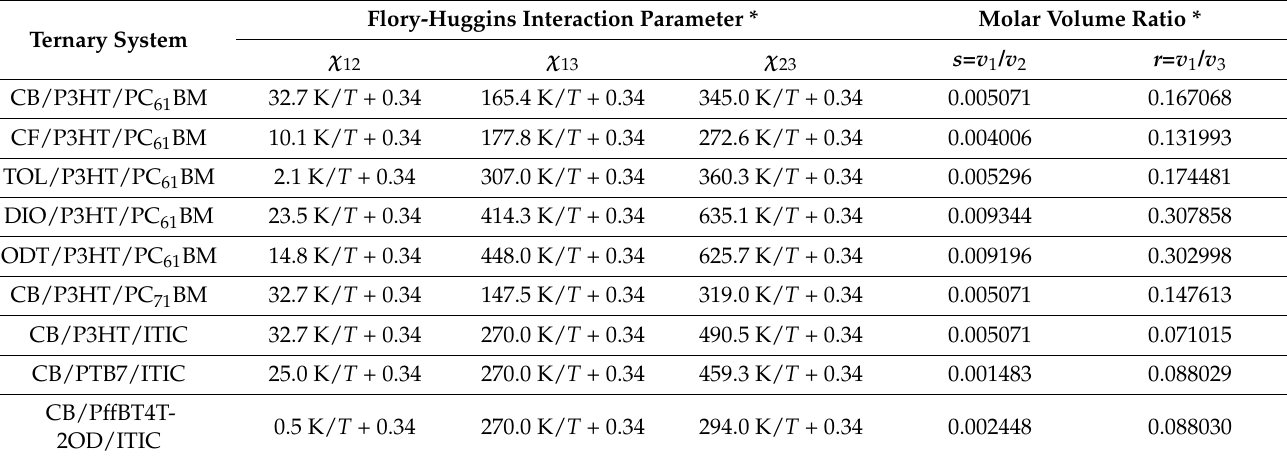
Table 3. Flory-Huggins interaction parameters and the molar volume ratios for the ternary systems. Flory-Huggins Interaction Parameter Ternary System